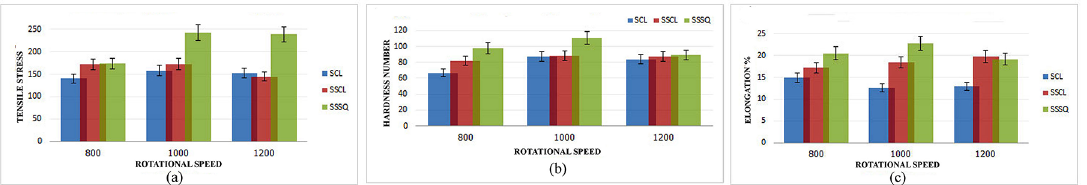
Figure 6. Error bar (a) Tesnile Stress (b) Hardness (c)